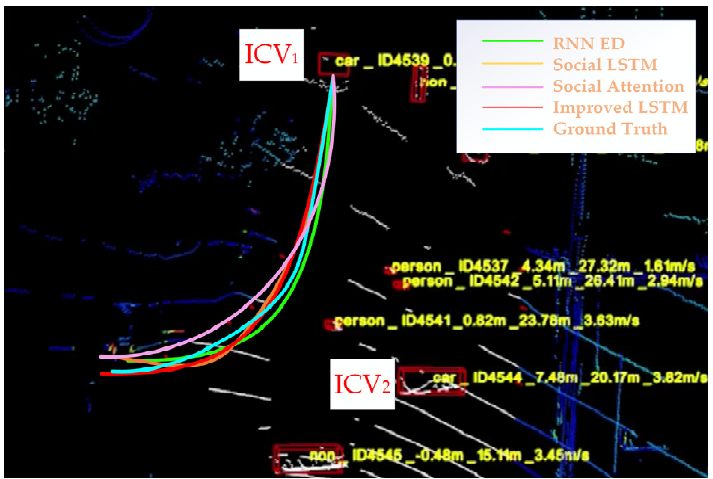
Figure 11. Real-time trajectory prediction results for the driving behavior of a right turn.